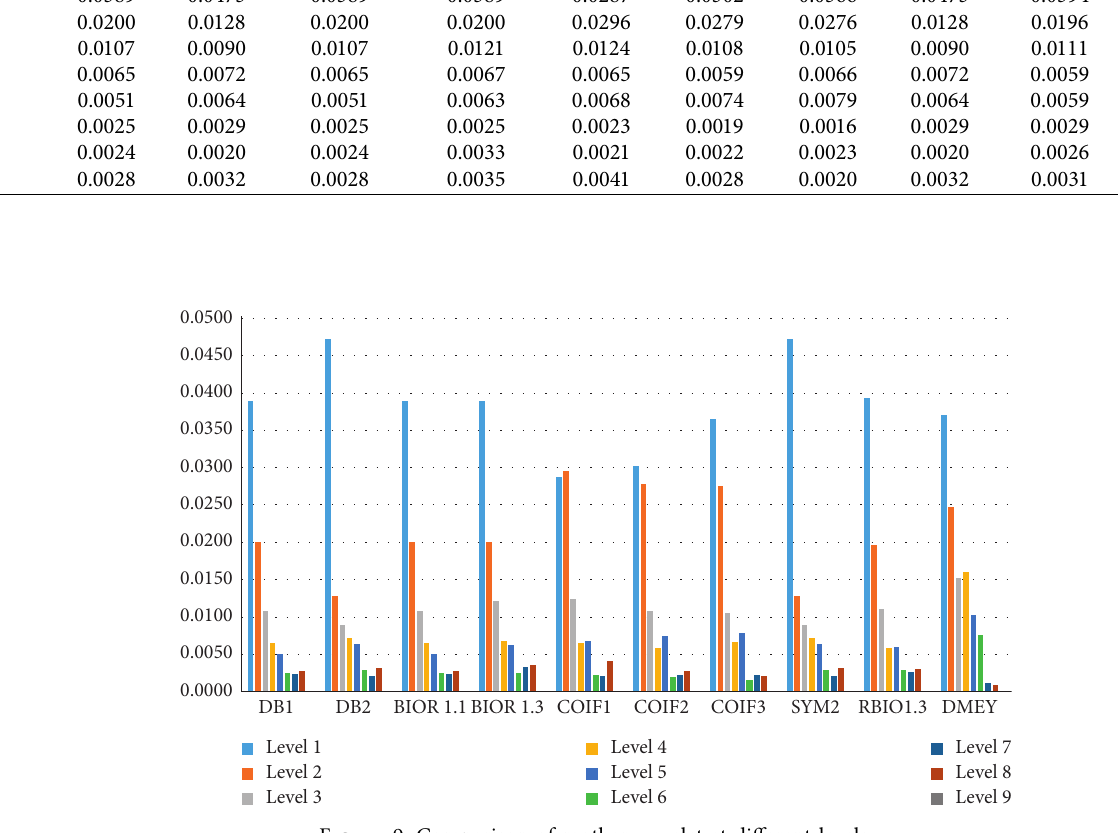
Figure 9: Comparison of mother wavelet at different levels.